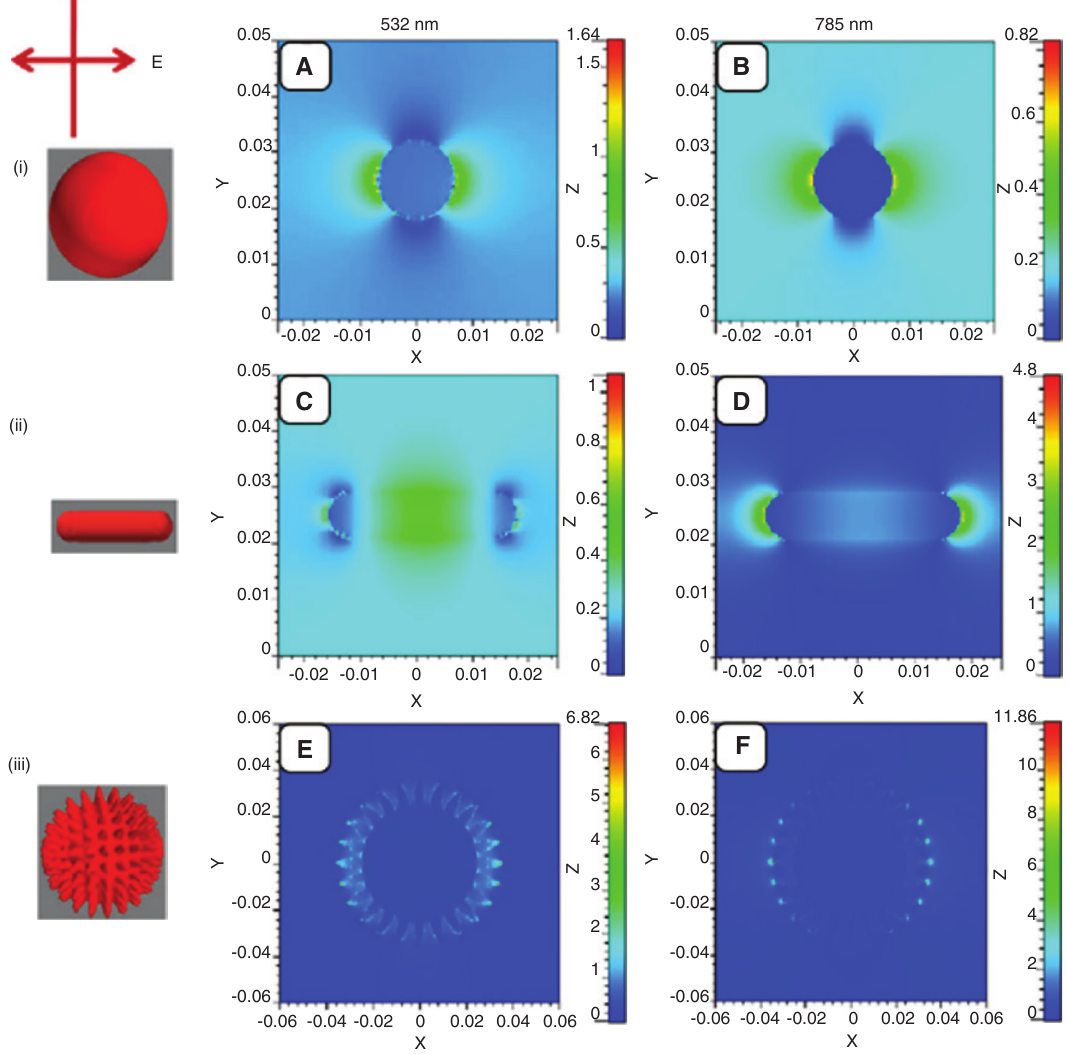
Figure 2: 3D FDTD simulated electromagnetic field distributions of a gold (i) nanosphere, (ii) nanorod, and (iii) nanostar under excitations of [(A), (C), (E)] 532-nm and [(B), (D), (F)] 785-nm lasers. The intensity scale is normalized as E = E Publishing. Reproduced with permission. All rights